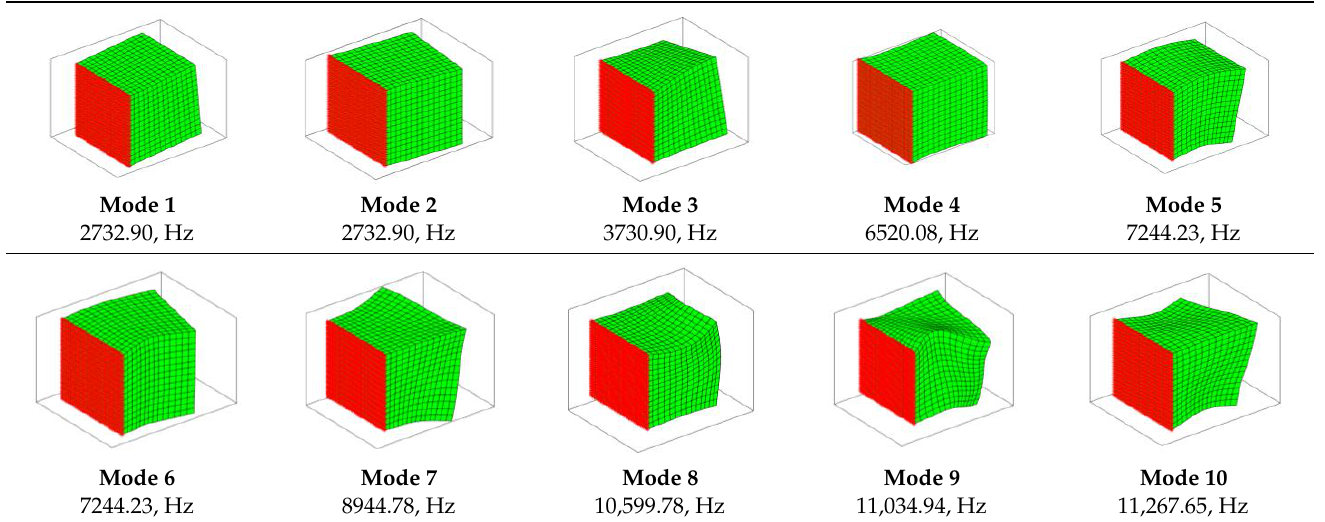
Table 4. Natural frequencies and modal shapes of the first 10 modes computed for the reference model.